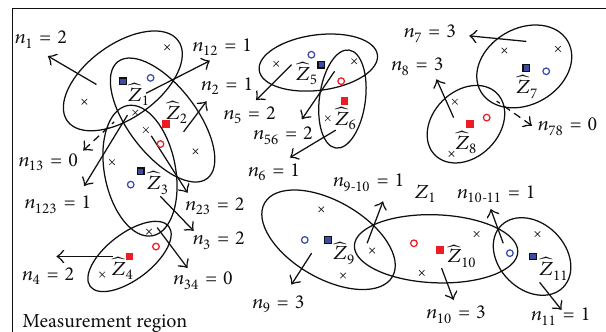
Figure 3: An example of measurement validation regions for a large number of